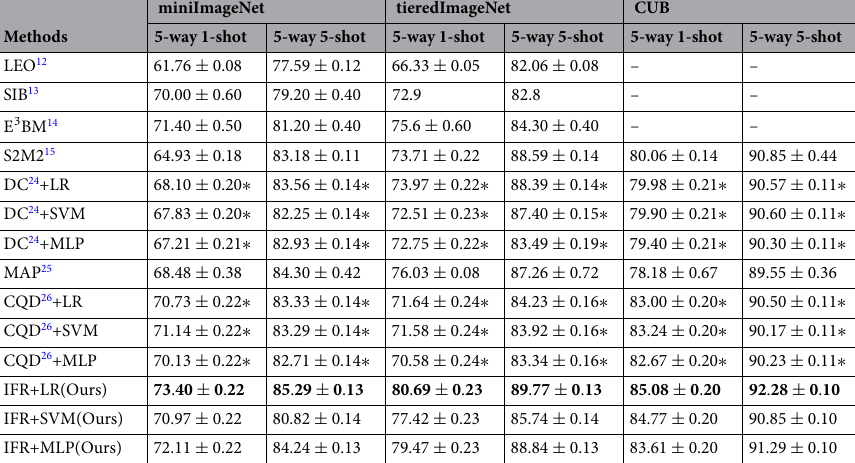
Table 1. 5-way 1-shot and 5-way 5-shot classification accuracy(%) on miniImanegNet, tieredImageNet and CUB. * indicates the result is reported by our reimplementation. ± indicates 95% confidence interval. The numbers in bold indicates the best